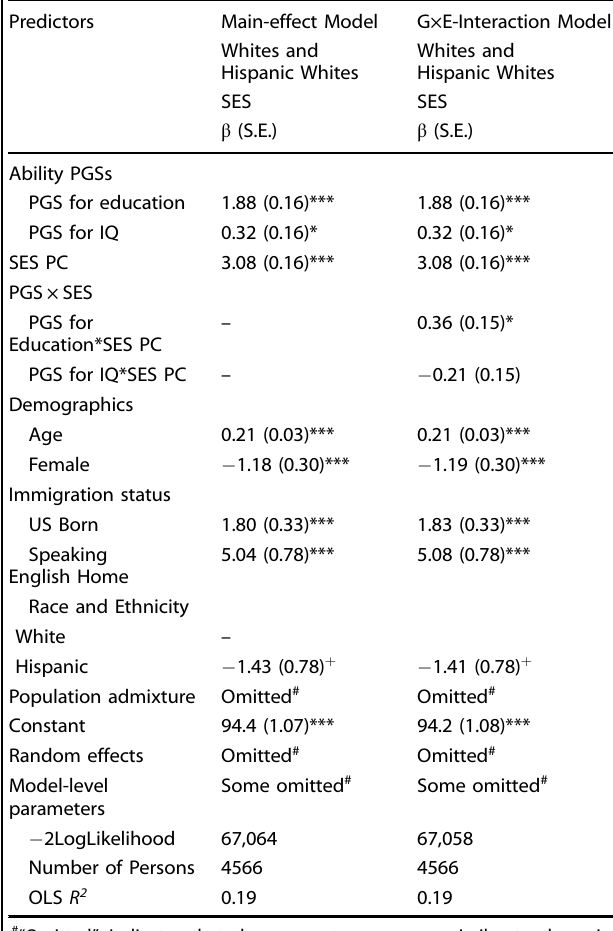
Table 6. Multilevel models of Wave-1 and 3 verbal ability showing G×E-interaction coef fi cients (standard errors) between an SES principal component and the two ability-related